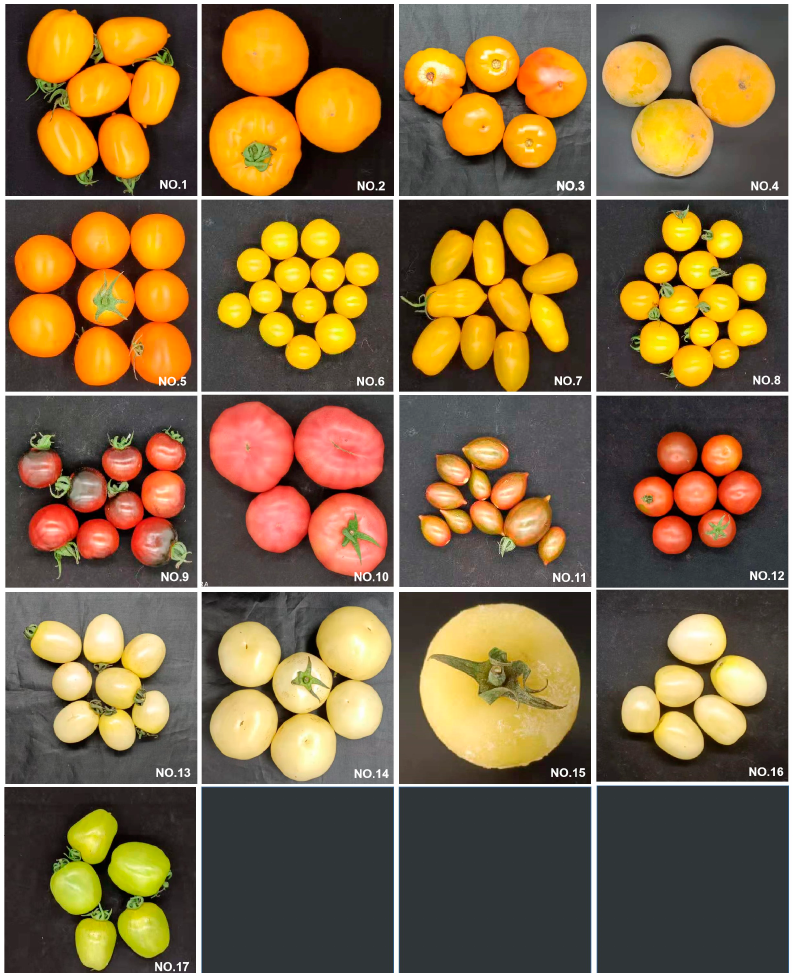
Figure 2. The appearance of tomato varieties. Table 2. The content of PT, PTF and LYC in 17 tomato varieties.